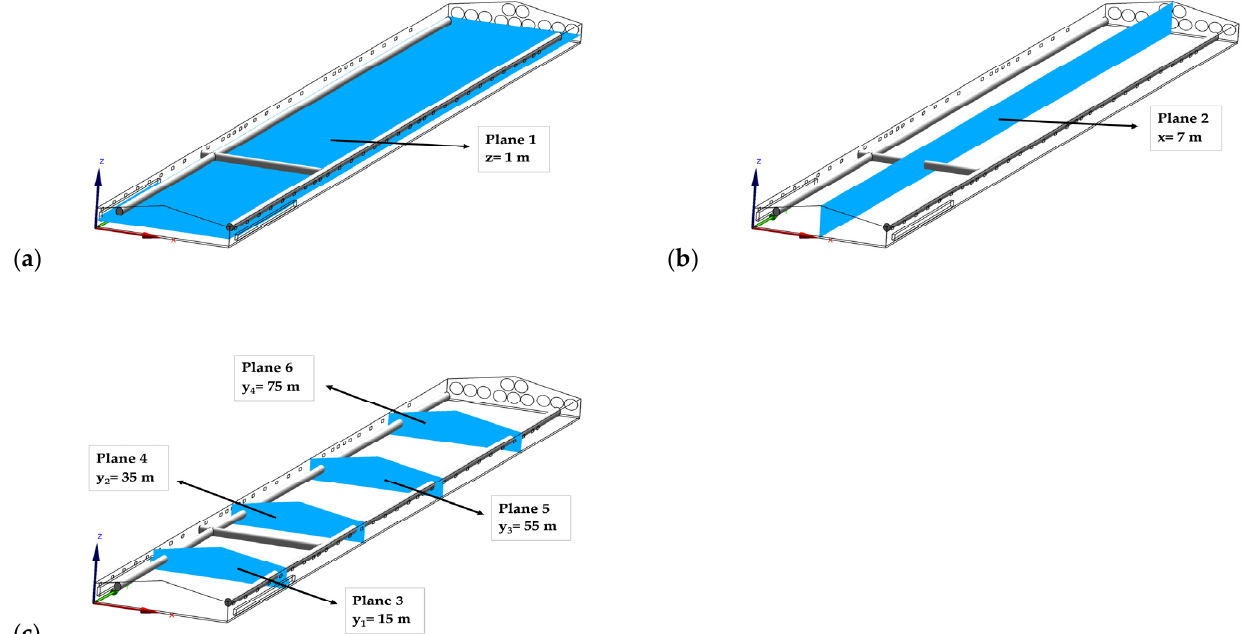
Figure 4. Locations of planes: ( a ) z = 1 m, ( b ) x = 7 m, and ( c ) y 1 = 15 m, y 2 = 35 m, y 3 = 55 m, y 4 = 75 m, and x = 7 m for illustration of spatial variations of the microclimate. y 4 = 75 m, and x = 7 m for illustration of spatial variations of the